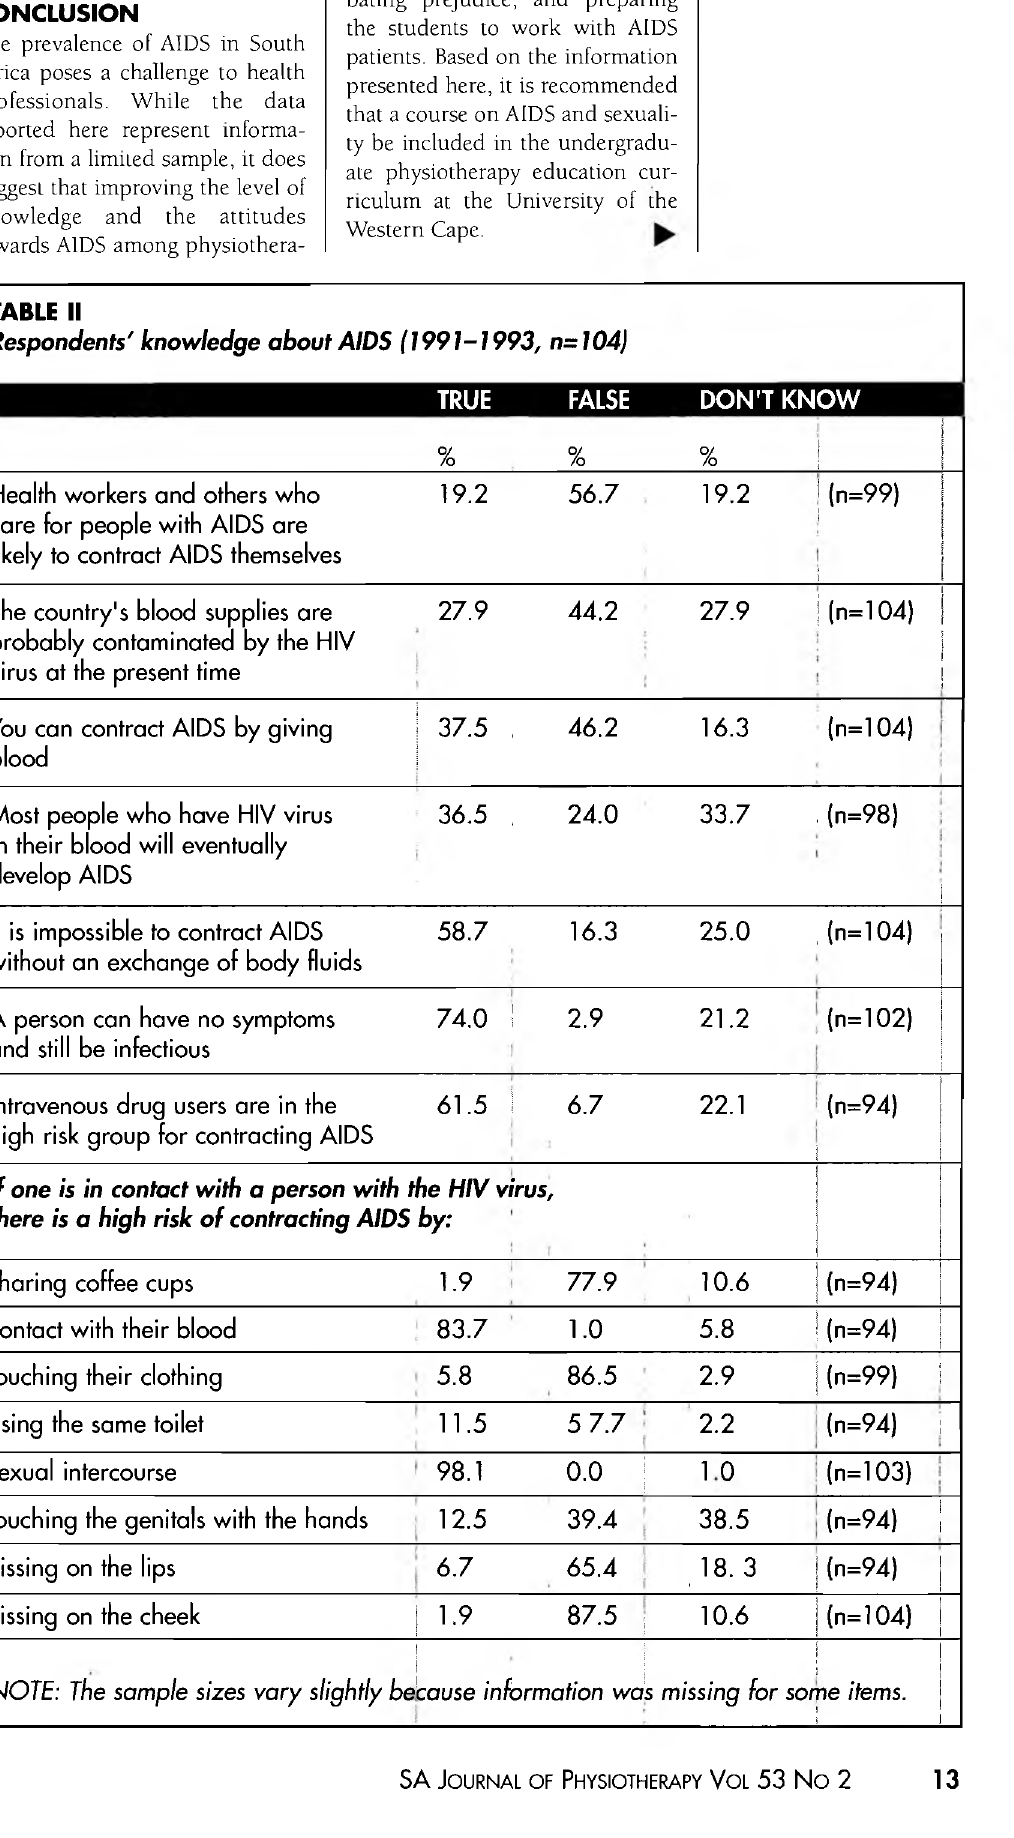
Respondents' knowledge about AIDS (1991-1993, n=